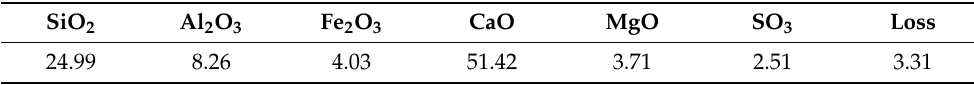
Table 1. Chemical composition of the Portland cement (wt